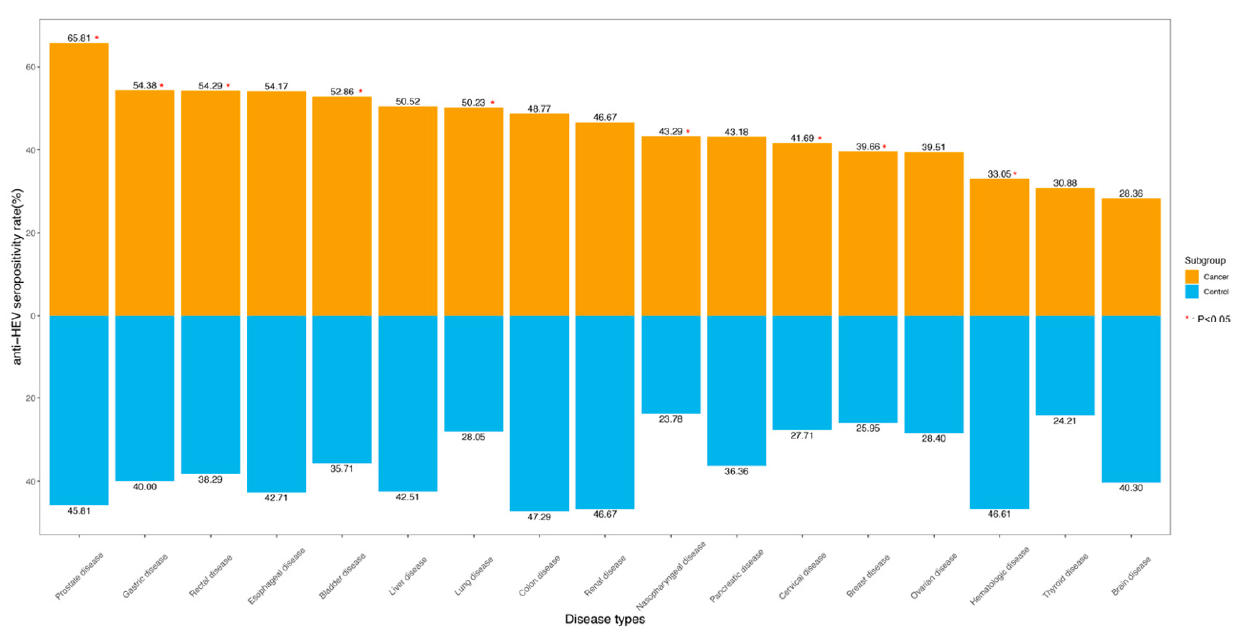
Figure 2. Anti-HEV seropositivity rates among cancer patients and non-cancer patients based on 17 organ sites.